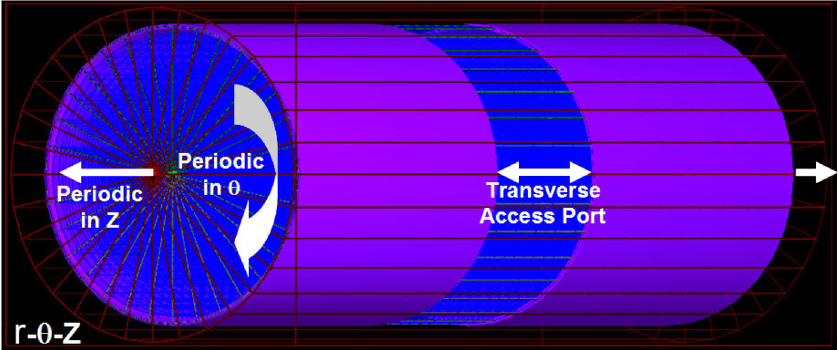
FIG. 9. (Color) Simulation space setup of the 3D ferroelectric source in the LSP code. The regions where plasma is produced are indicated by purple cylindrical shells.